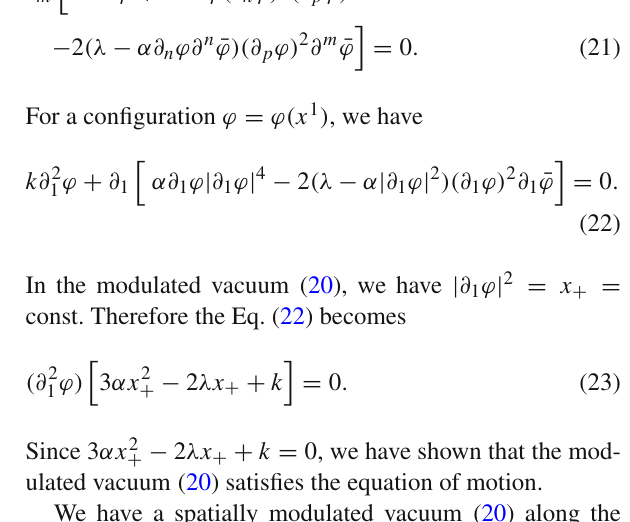
Fig. 1 Schematic pictures of the energy function E ( x ) , the potential for x = | ∂ 1 ϕ | 2 . The vertical axis stands for the energy E ( x ) while the horizontal axis for x . The local vacua for a positive, b zero and c nega-